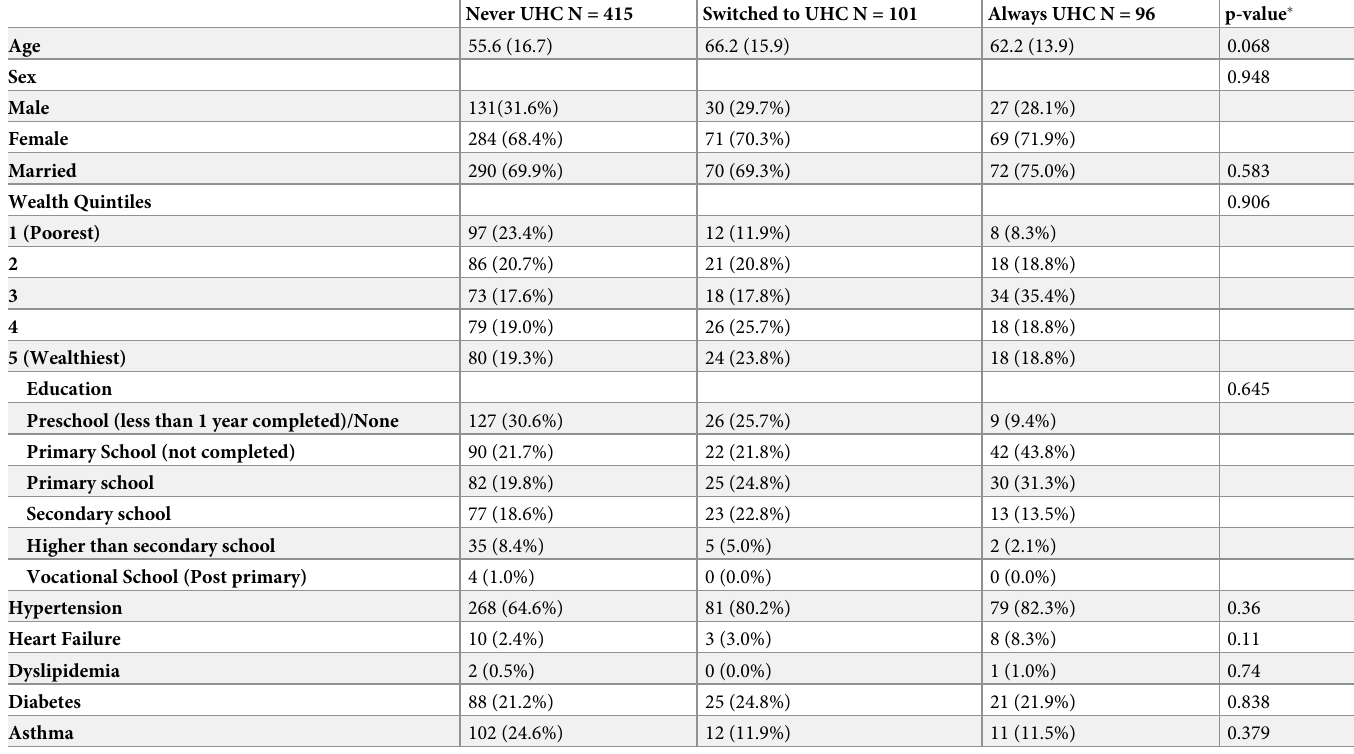
Table 1. Summary of baseline demographics by UHC